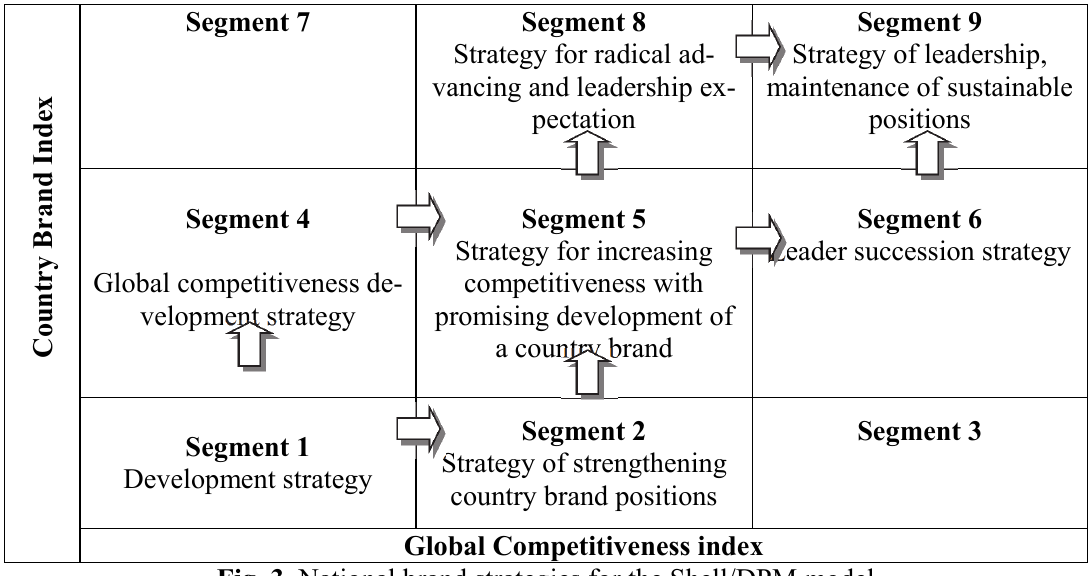
Fig. 3. National brand strategies for the Shell/DPM